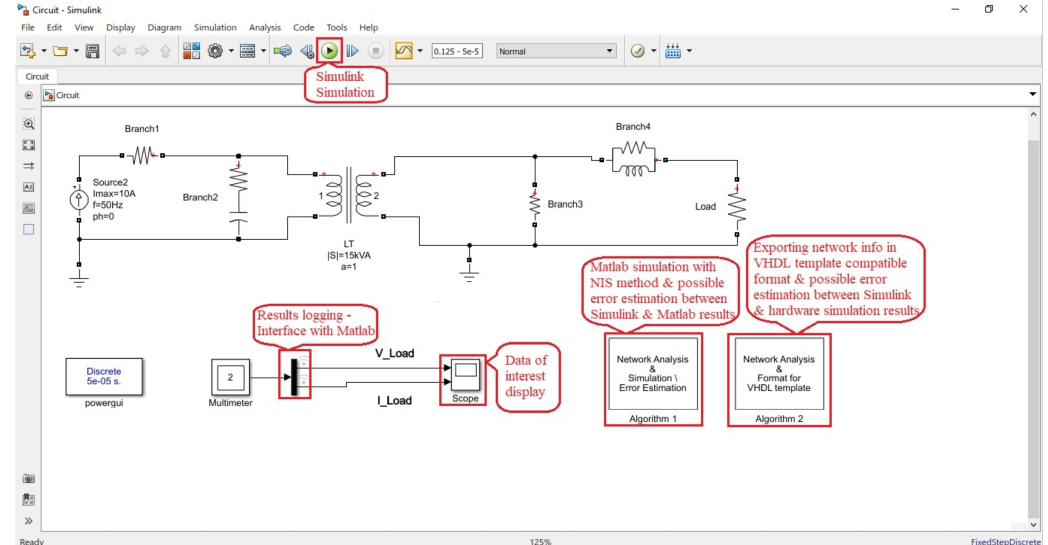
Figure 16. Test network designed in Simulink General User Interface (GUI); important details and tools are marked in